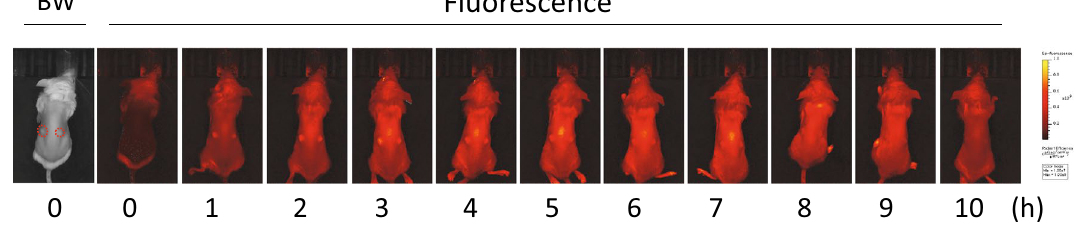
Figure 1. Temporal changes in PPIX fluorescence after ALA administration. A mouse with intradermal tumors (both sides of the back, indicated by dashed-line circles in the black-and-white (BW) photo) was transesophageally administered 300 mg/kg of ALA, and PPIX-derived fluorescence was measured every hour up to 10 h after